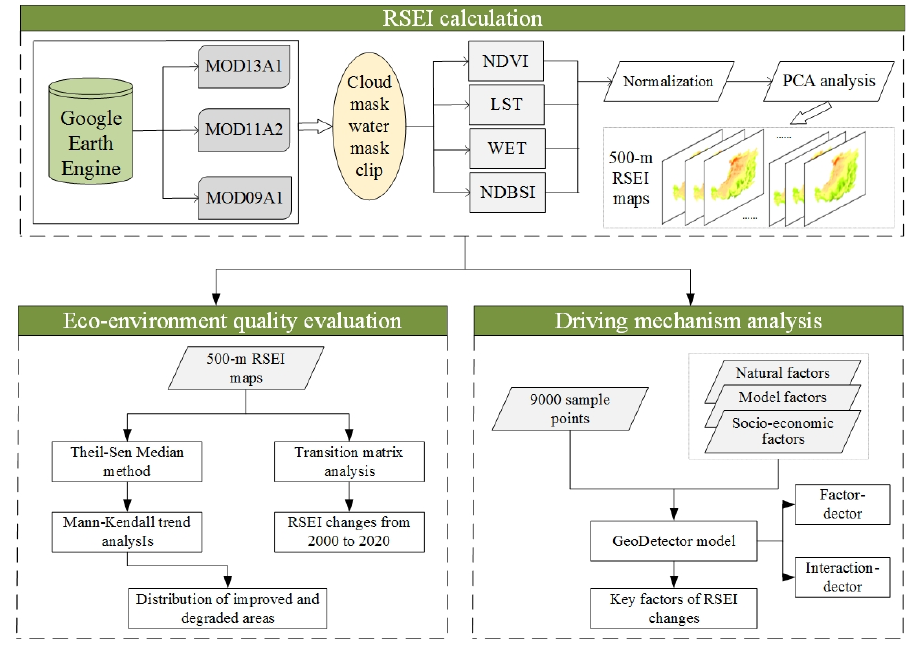
Figure 2. Technology flowchart.